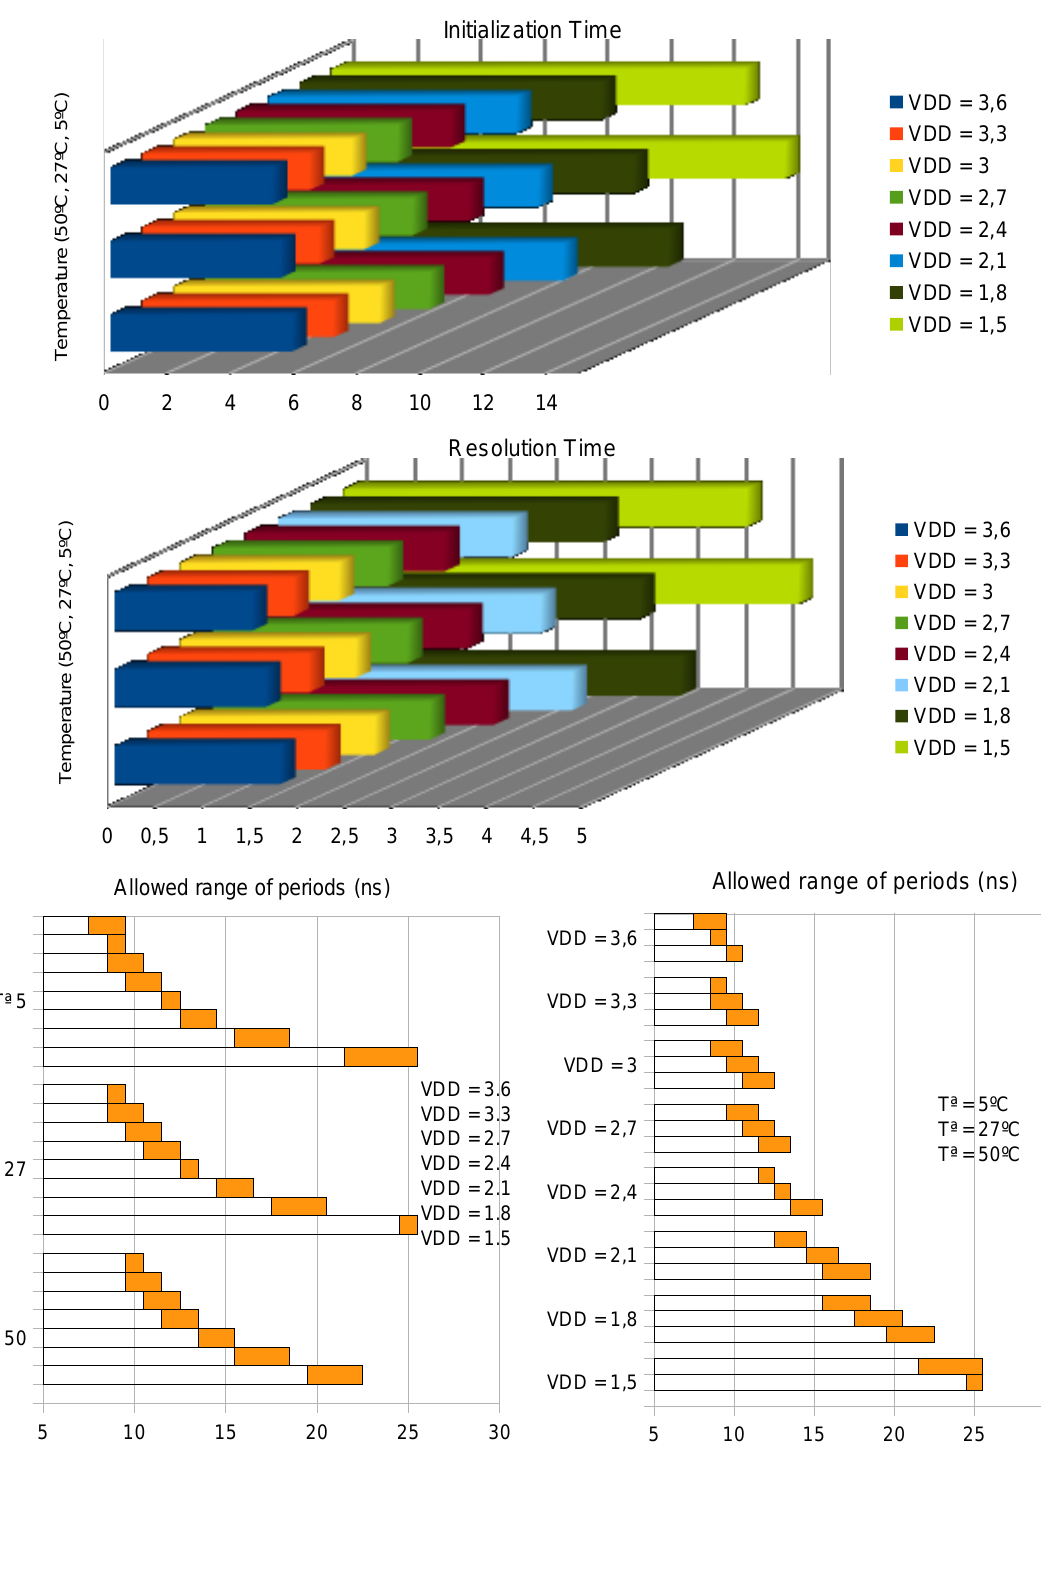
Figure 10. Study of the sensor behavior varying temperature and supply